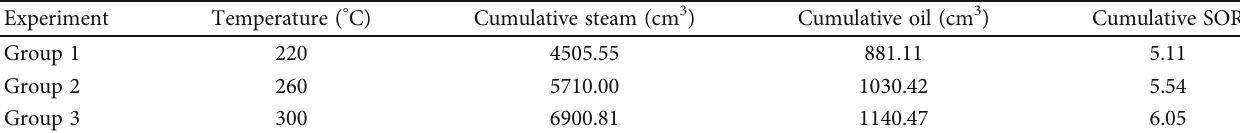
Table 3: Experimental results of cumulative SOR.